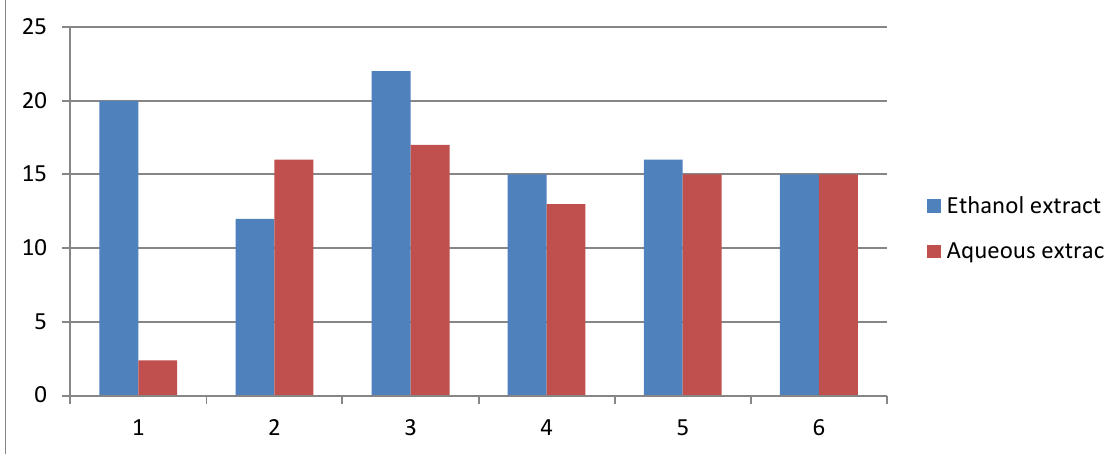
Figure 2. Antibiotics sensitivity